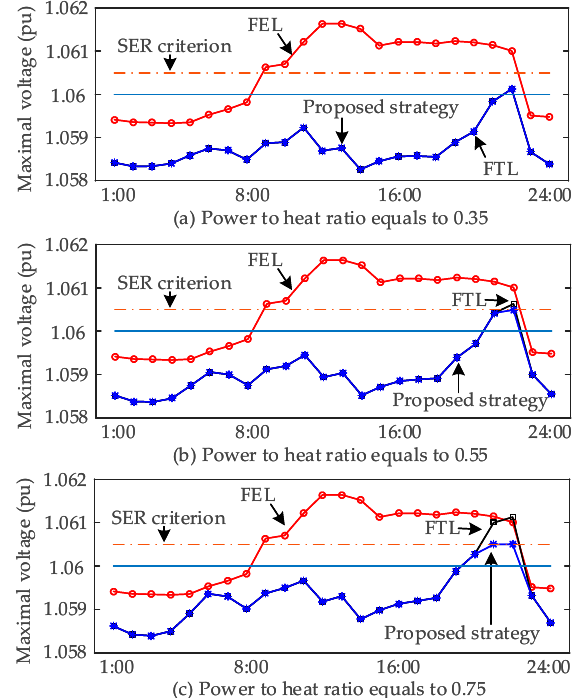
Figure 8. Maximal voltages under different control strategies in summer (power to heat ratio of CHP generation is set with diverse value, where ( a ) C = 0.35; ( b ) C = 0.55; and ( c ) C =